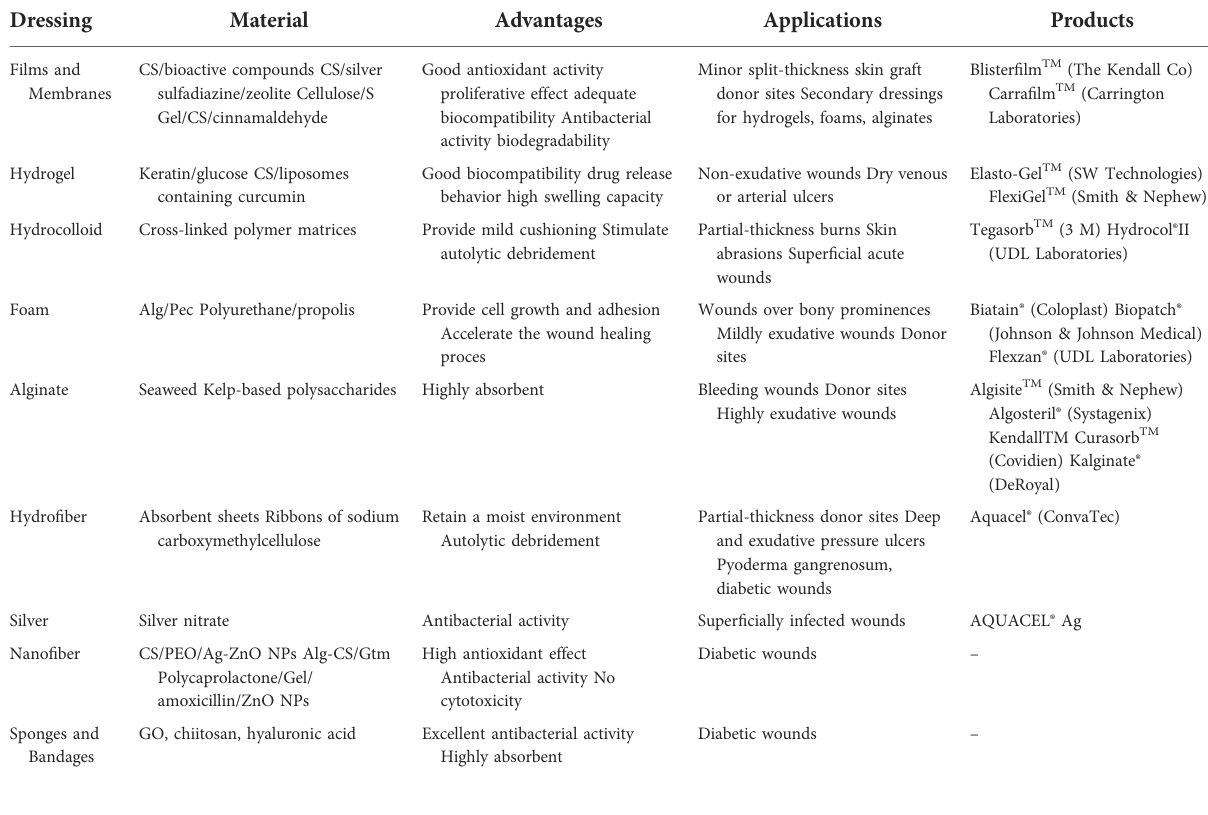
TABLE 2 Different types of wound